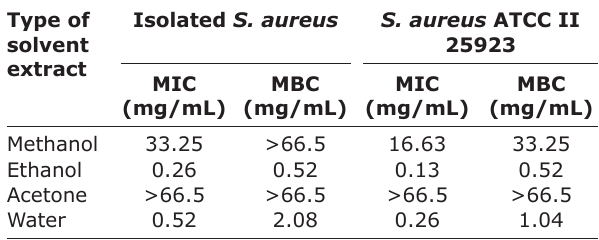
Table-1: MIC and MBC of H. isora extract against S. aureus. Type of Isolated S. solvent extract